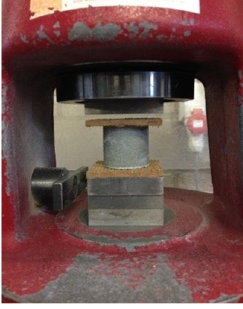
Figure 3. Compressive strength sample setup.